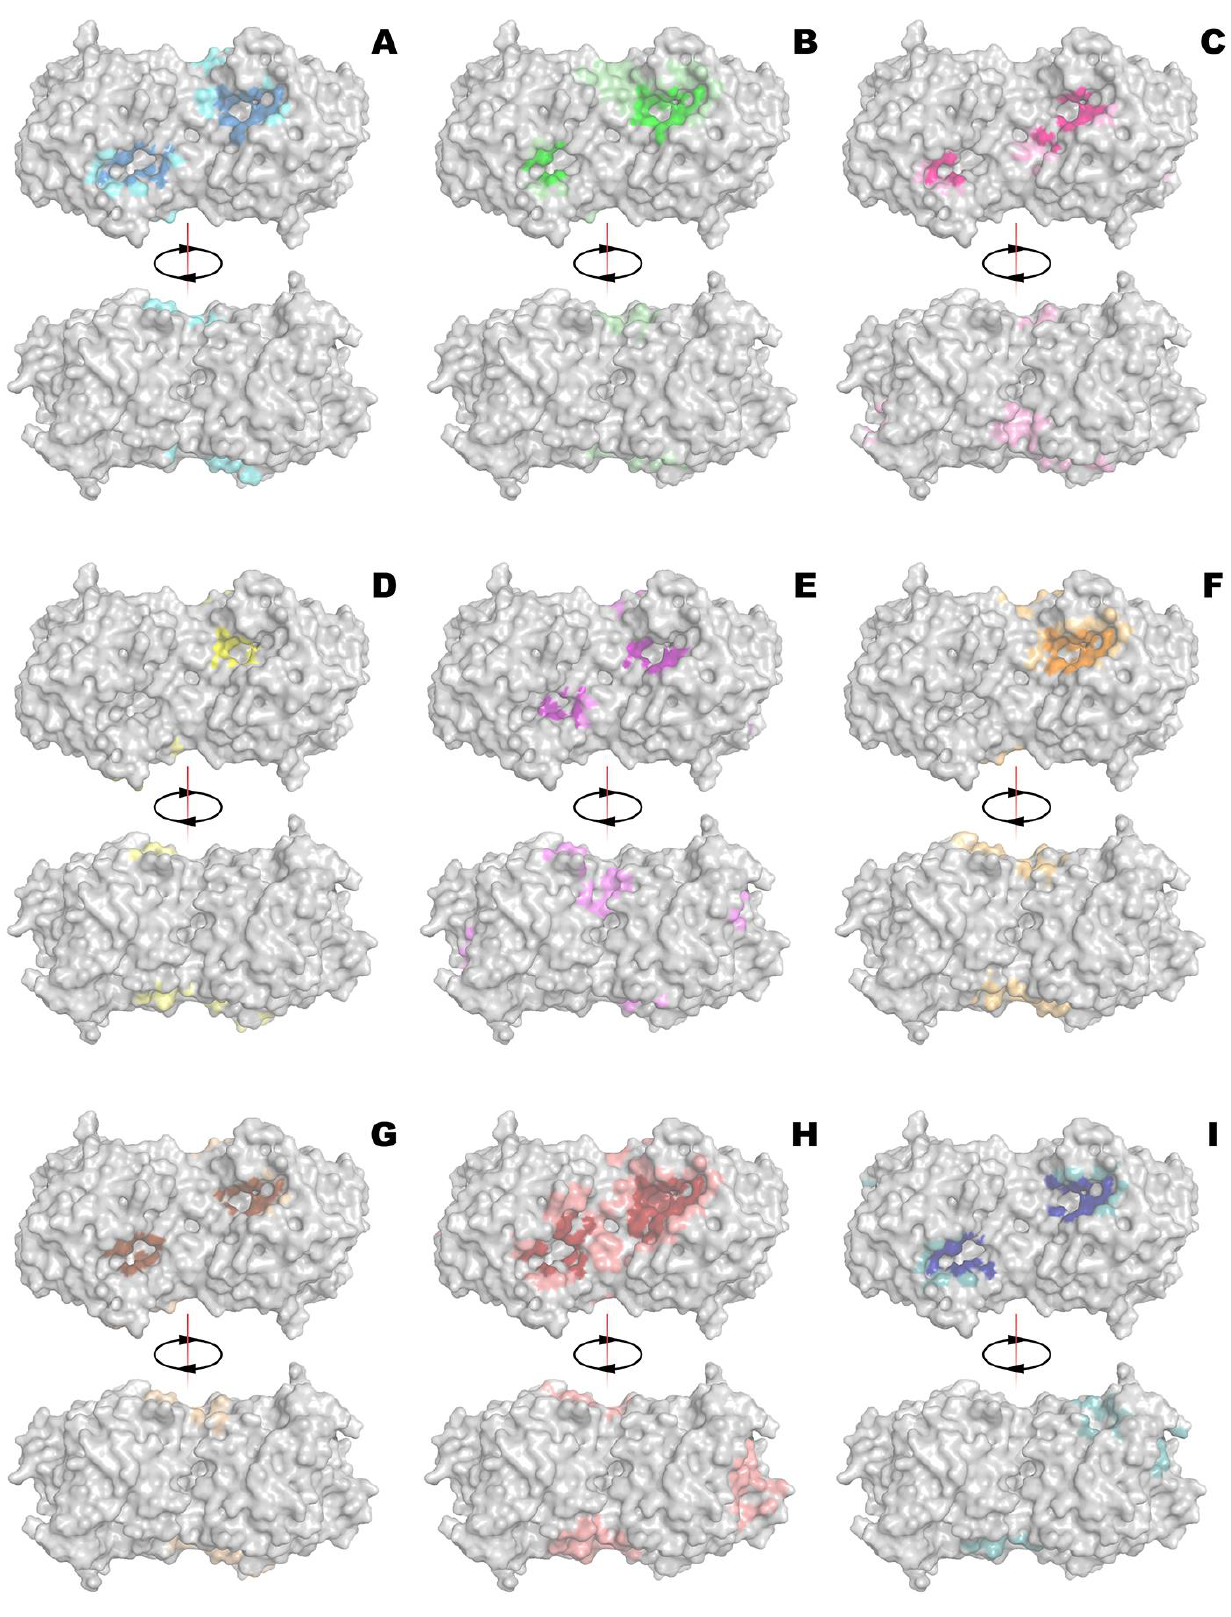
Figure 2. Binding of amentoflavone ( A ), apicidin ( B ), DIPT ( C ), emodin ( D ), naringenin ( E ), ngercheumicin A ( F ), savirin ( G ), UP5 ( H ) and amirinic acid ( I ) to front and back side of His 6 -OPH. Occupied surface near active site is highlighted by more intensive color. The top binding poses of emodin and naringenin near active sites are illustrated on Figure S4.